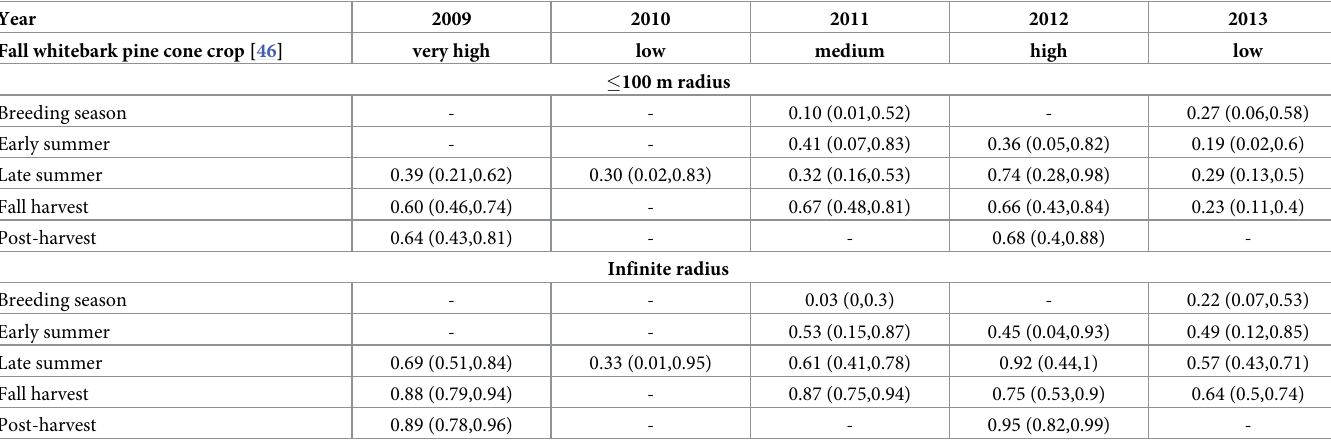
Table 4. Posterior mean year-stage detection probabilities and 95% Bayesian Credible Intervals. Dashes indicate stage-year combinations without